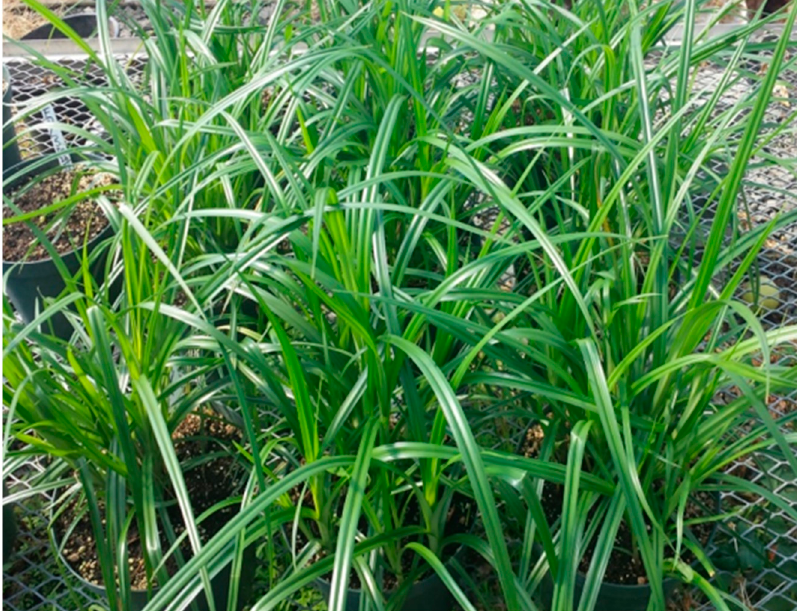
Figure 3. Typical appearance of tigernut plant in 20-cm diameter pots grown in Pro-Mix (BX brand) in the hoop house at 6 weeks after transplanting (Photo: Albert Ayeni).